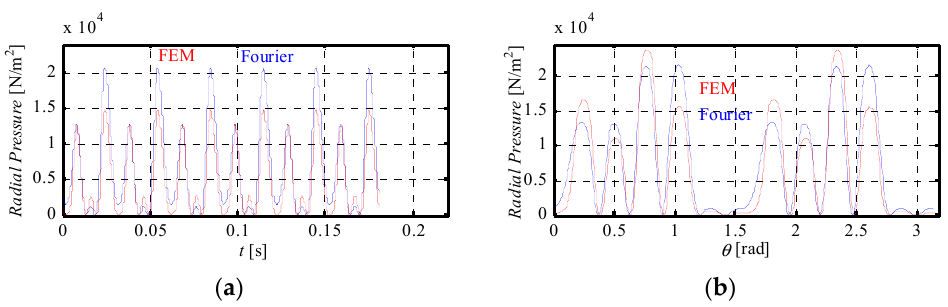
Figure 12. Magnetic pressure distribution created by stator coils on the rotor surface of the Qs48p8 machine: ( a ) temporal, ( b ) spatial.